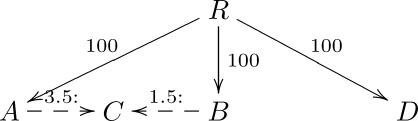
Simulation of an Admixed PopulationWe show a simple demography generating an admixed population. Populations A,B,D trifurcated 100 generations ago, while population C is a recent admixture of A and B. Admixture weights for the proportion of population A in population C are Beta-distributed with parameters (3.5,1.5). Effective population sizes are 10,000.